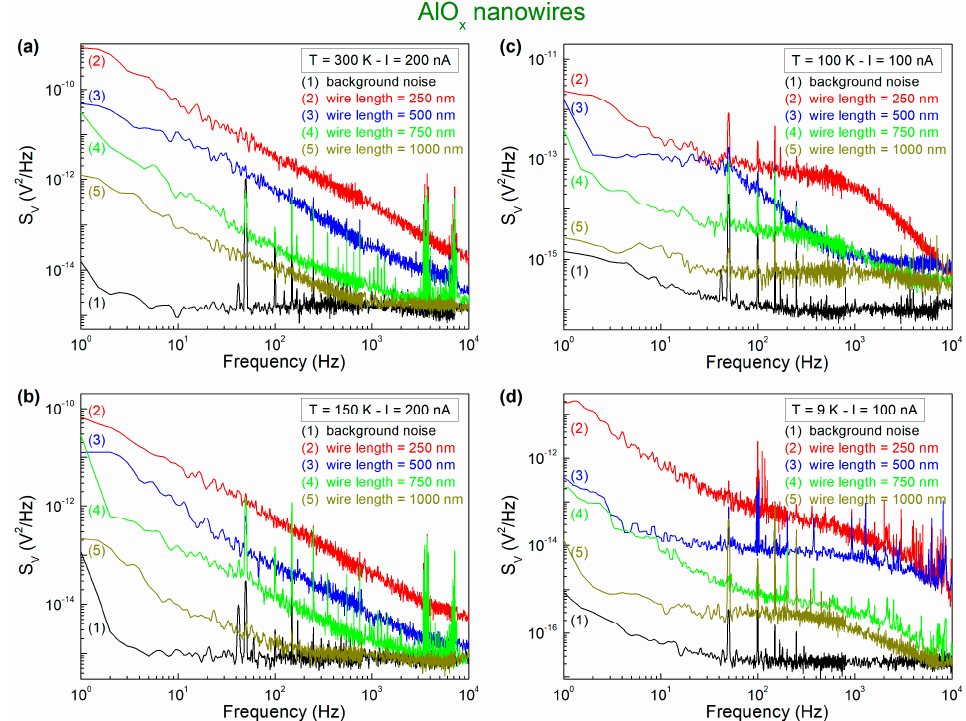
Figure 4. Voltage-noise spectra. The frequency dependence of S V is shown for all of the investigated nanodevices for two bias currents and four different temperatures: 300 K ( a ), 150 K ( b ), 100 K ( c ), and 9 K ( d ). The black trace, which is the lowest spectral trace for each temperature, shows the unbiased noise, which is composed by the instrumental, the external, and the sample Johnson noise.